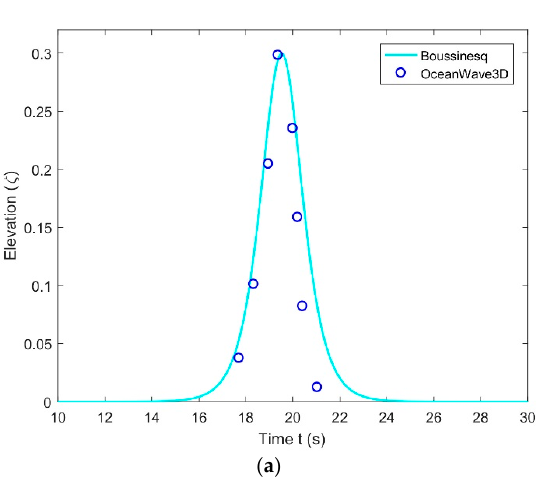
(see [31]) versus time t (s).